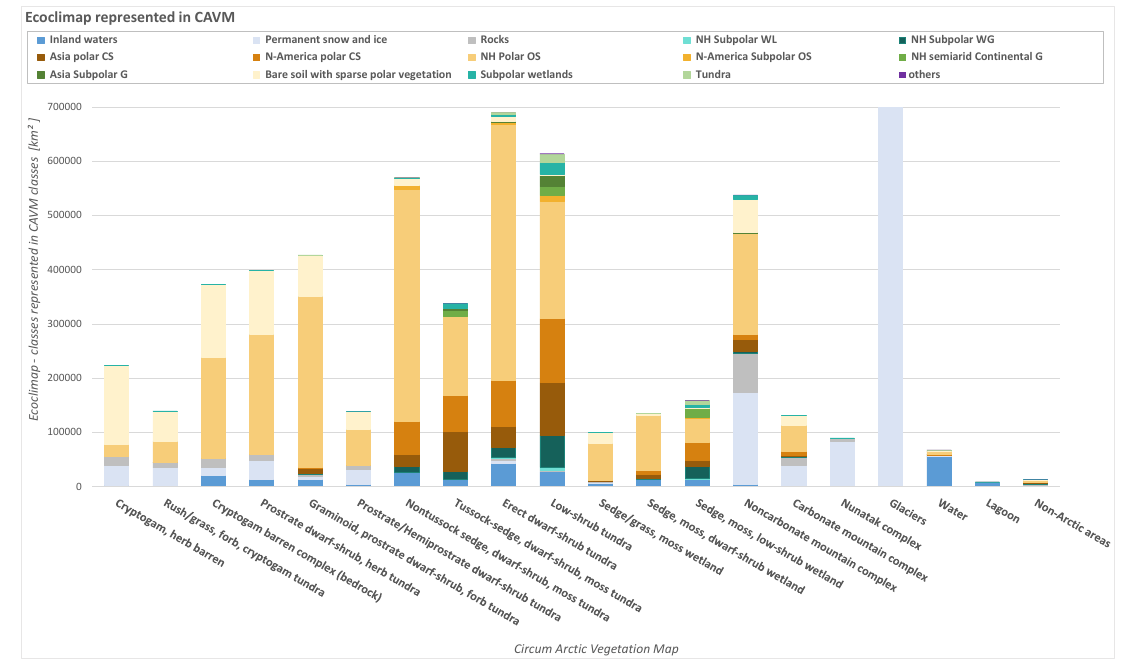
Figure 4. Comparison of ECOCLIMAP classes with CAVM [5].